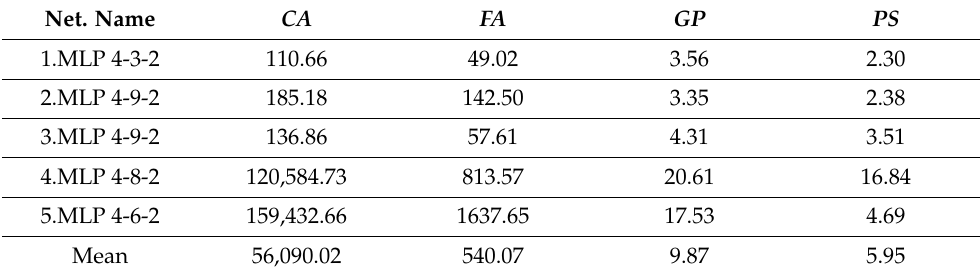
Table 12. Evaluation the sensitivity of neural networks to input variables.